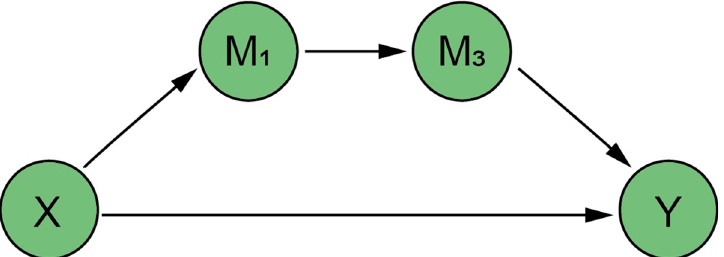
Fig 2. Chain-mediated path 2: Air quality, labor